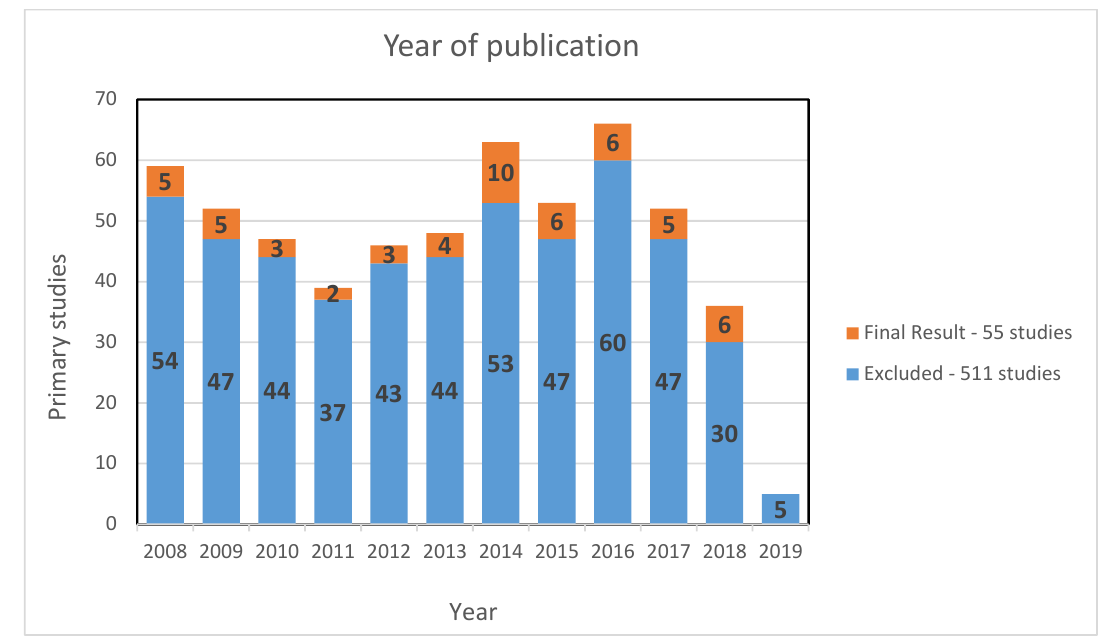
Figure 2. Relation between publish year and number of papers (source: own study).